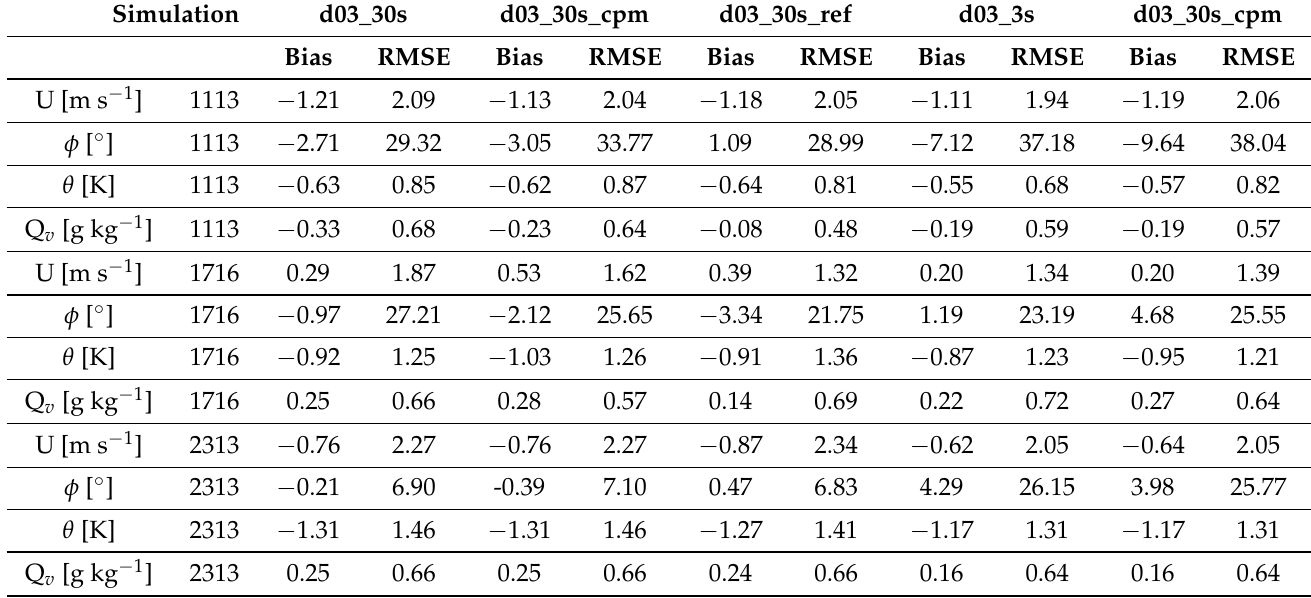
Table 4. Biases and root-mean-square errors (RMSE) comparing LES results to GAUSS radiosonde data from soundings released from the center of the Vale do Cobrão (red ‘x’ in Figure 2) at 11:13:11 UTC, 17:16:25 UTC, and 23:13:28 UTC. Biases are averages of the difference taken as model data minus observed radiosonde data interpolated to the heights of the LES model levels below 5 km above sea